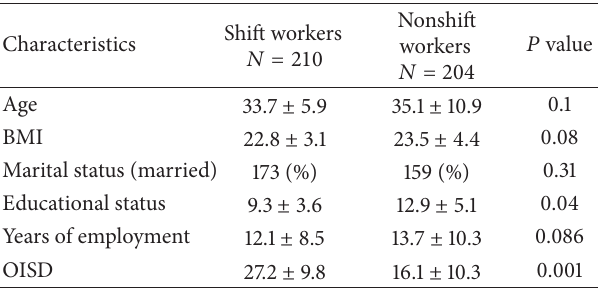
Table 1: Baseline characteristics in two groups of shift workers and nonshift